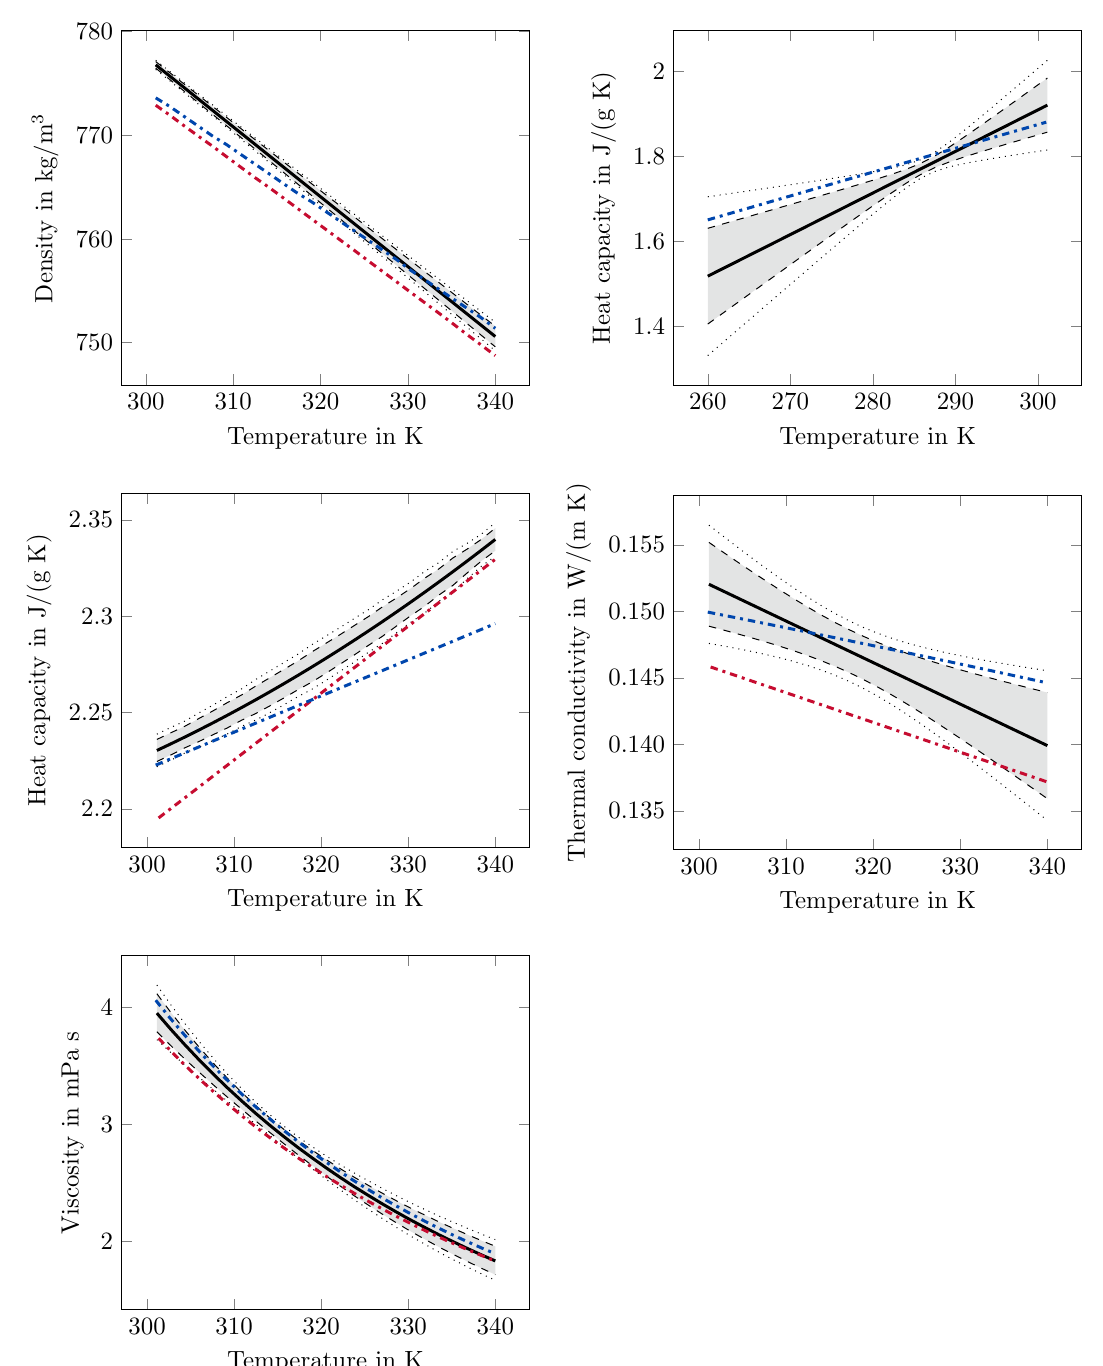
Figure A1. Comparison of the estimated fit functions with functions from literature. The black lines are the estimated fit functions from table 6 (solid line) and the corresponding confidence intervals of 95 % (dashed line) and 99 % (dotted line) from Appendix A.1. The red and blue lines represent the functions from the VDI heat atlas [101] and from Yaws [104],